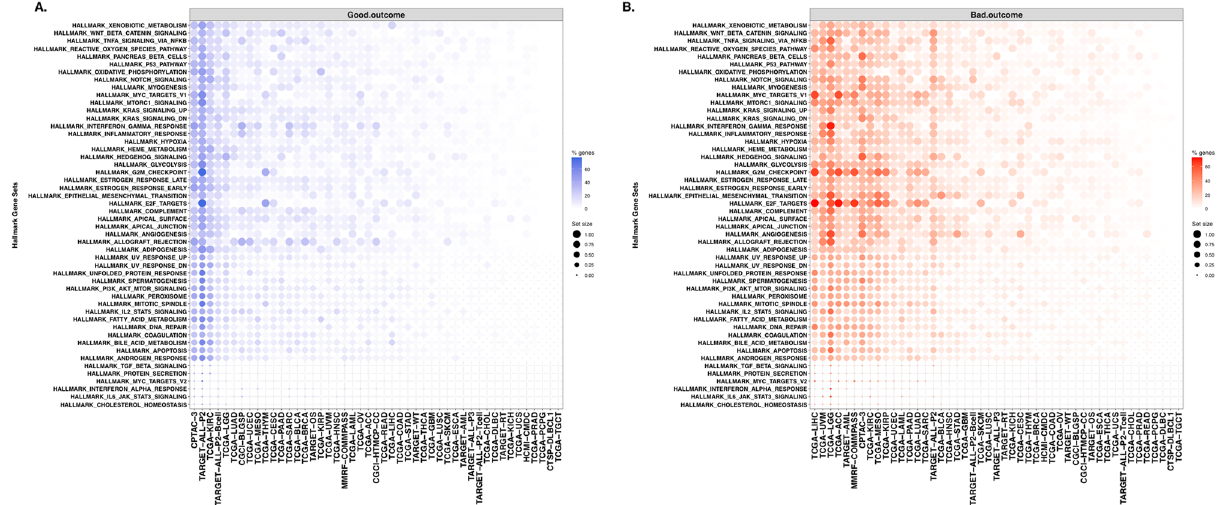
Figure 5. Hallmark genesets with enrichment of survival-associated genes. Summary of significantly associated hallmark genes with good ( A ) and bad ( B ) overall survival for each hallmark gene set for each cancer type. The dot color gradient represents the percentage of genes per gene set (% genes) that are significantly associated ( p -value < 0.05) with survival outcome, while the size of the dots represents the total number of genes within a gene set (set size). The blue and orange color gradients indicate the good (HR < 1) and bad (HR > 1) survival outcomes.